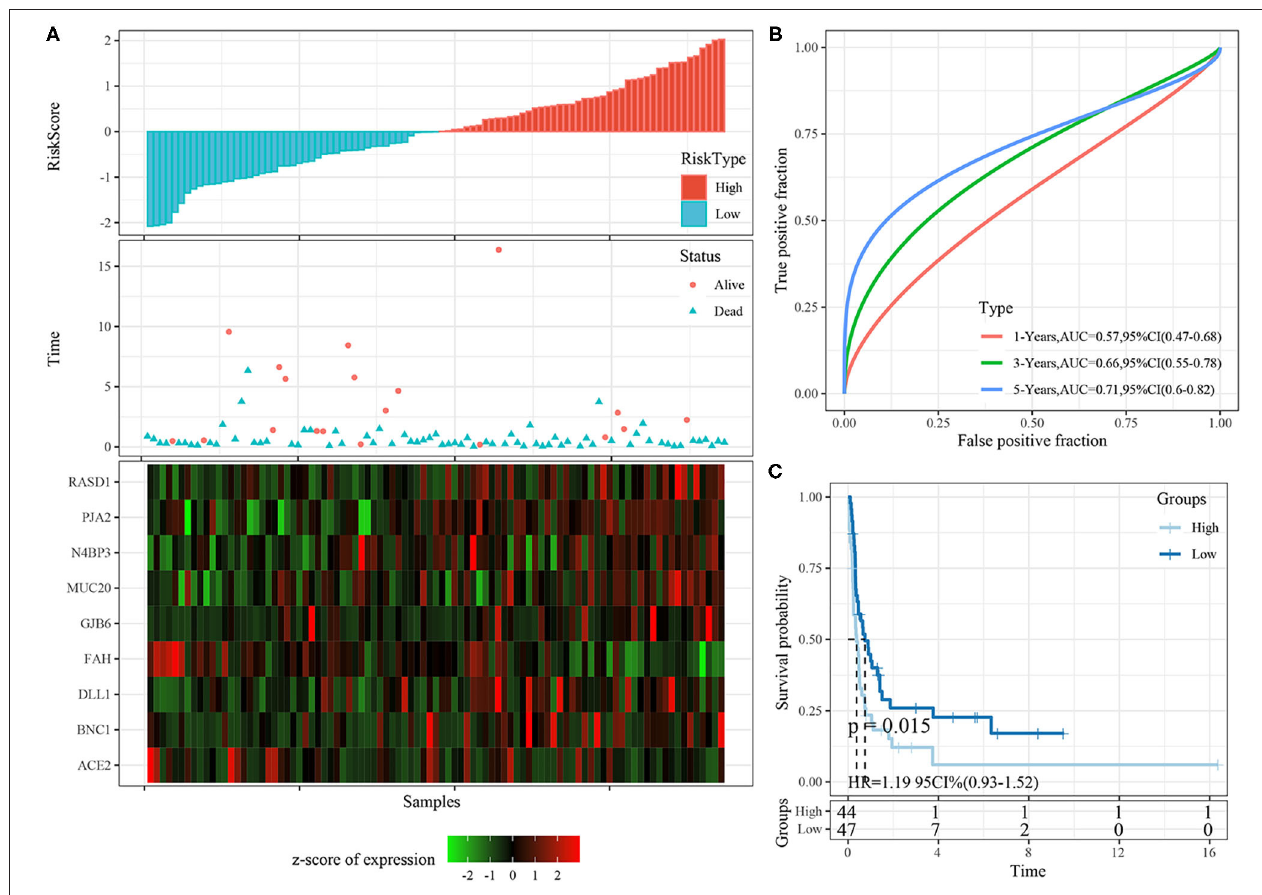
FIGURE 10 | (A) The distribution of risk score, survival time, and the expression of 9-gene in ICGC cohort; (B) The ROC curve and AUC curve of 9-gene signature in ICGC cohort; (C) The KM survival curve of 9-gene signature in ICGC cohort.